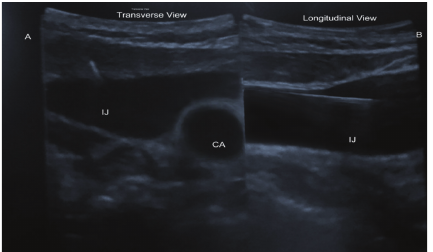
Figure 4: Real-time biplane view of the guide wire during central venous cannulation in our patient. The guidewire is visible in the lumen of the IJ in both views. IJ: internal jugular vein; CA: carotid